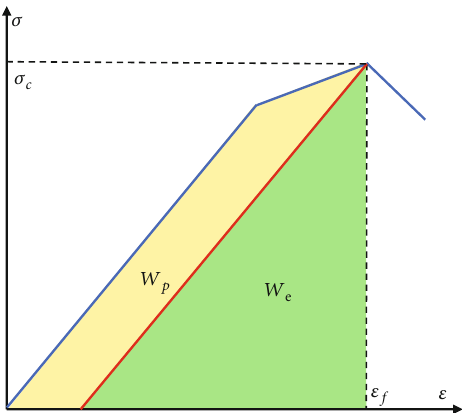
Figure 2: Evaluation of rock brittleness based on the prepeak